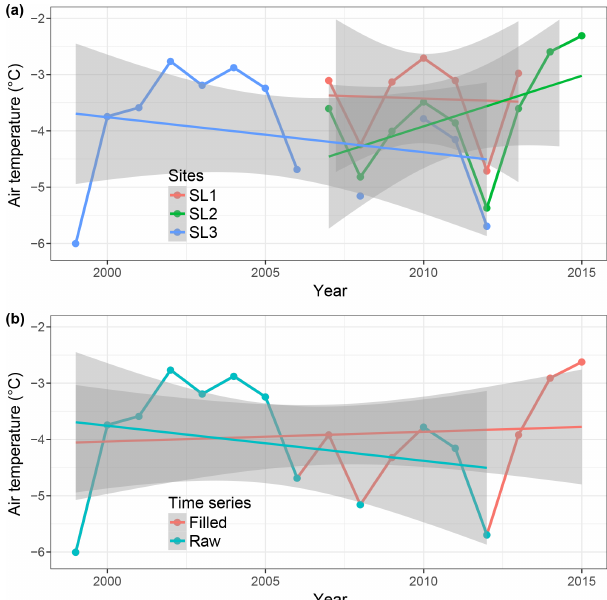
Figure 8. (a) Stations with at least 10 years of identical period of air, ground surface, and ground temperature at 0.5m. (b) Trend comparison of air temperature, ground surface temperature, and ground temperature at 0.5m over 1997–2016. Trends were only es- timated for those stations consisting of at least 10 years of data. Error bars represent standard errors from the linear regression anal- ysis. Circles indicate trends with a p value ≤ 0 . 05; triangles indicate trends with a p value > 0 . 05.